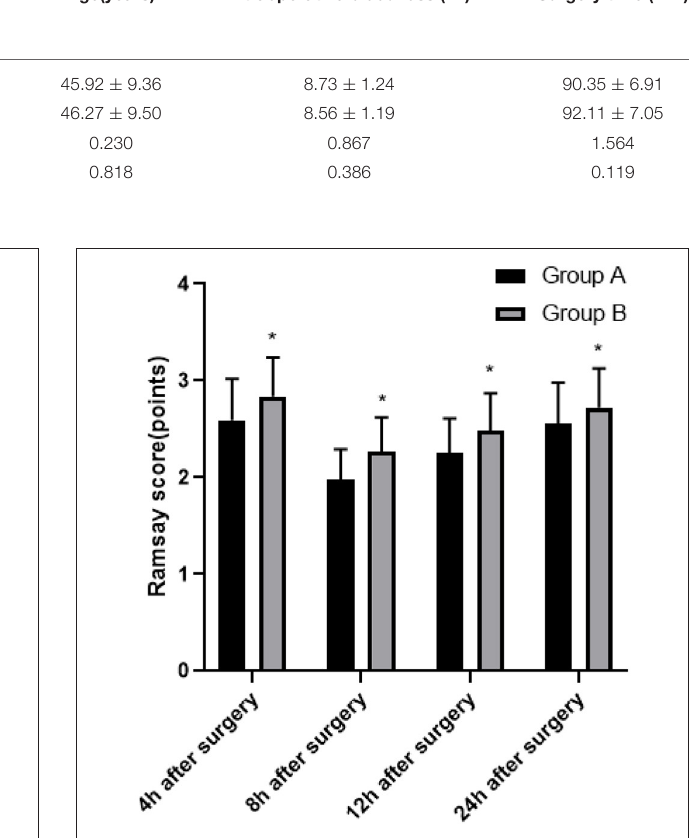
FIGURE 2 | Comparison of sedation situation between two groups. Compared with group A, * P <